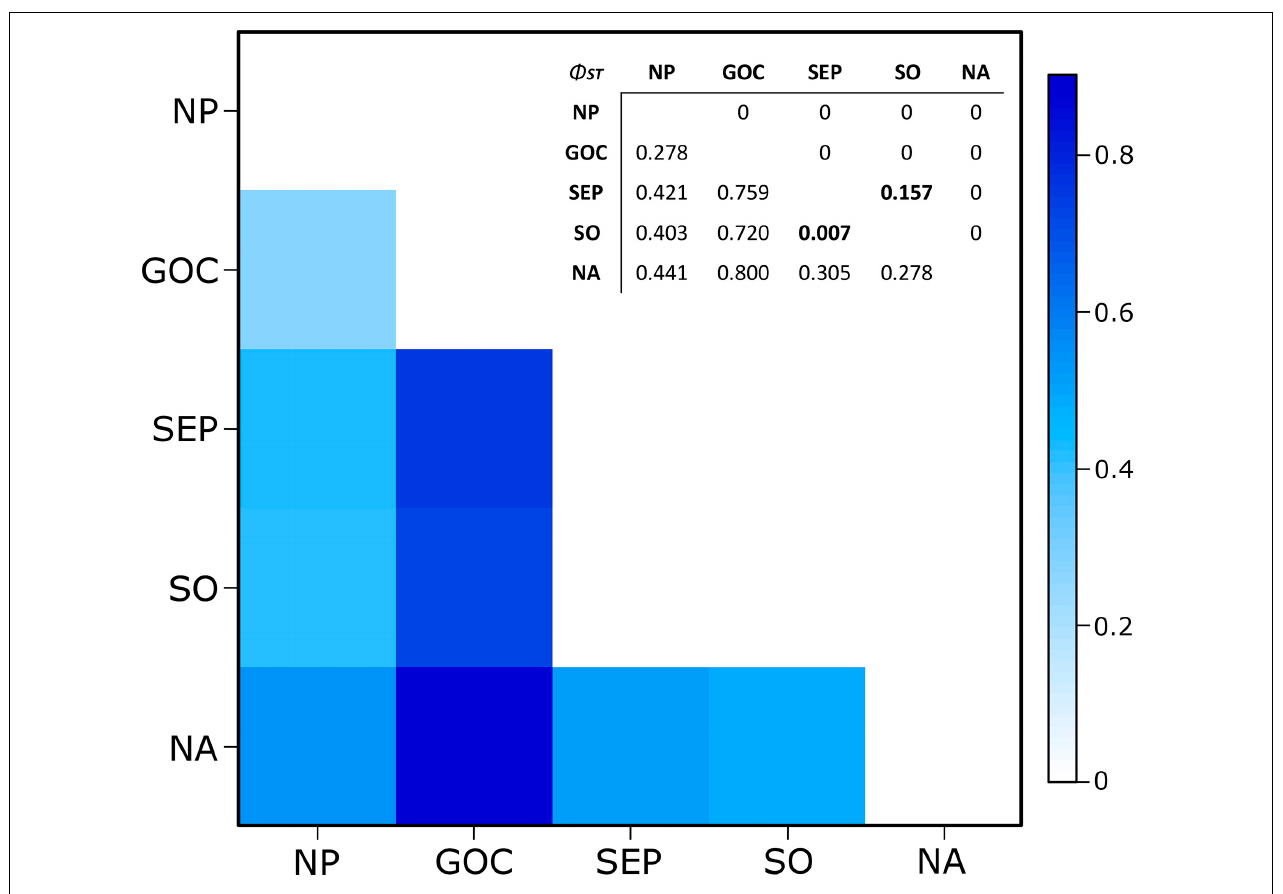
FIGURE 3 | Heatmap for the pairwise phylogeographic structure ( (cid:56) ST ) comparisons between the five geographic areas NP, GoC, SEP, SO, and NA. In the embedded table, values are given below the diagonal and p -values above it. Non-significant values are in bold. Note: 0 represent p <